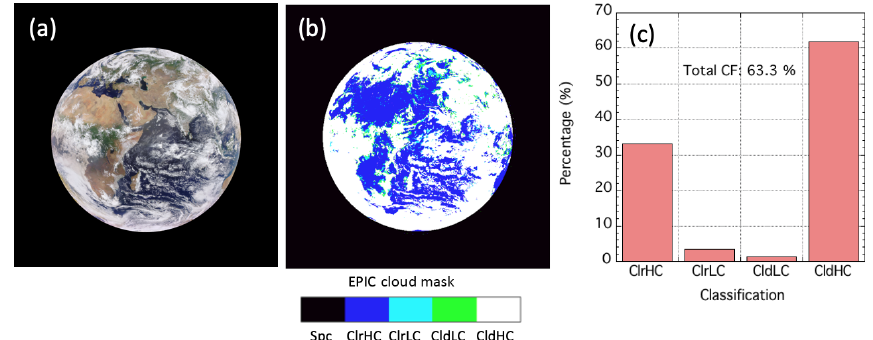
Figure 2. Sample EPIC L2 cloud products for the observations at 08:00UTC on 18 August 2016: (a) EPIC RGB image and (b) EPIC cloud mask. Spc: space pixels, ClrHC: clear with high confidence, ClrLC: clear with low confidence, CldLC: cloudy with low confidence, and CldHC: cloudy with high confidence. (c) Percentage of each scene type derived from the cloud mask.